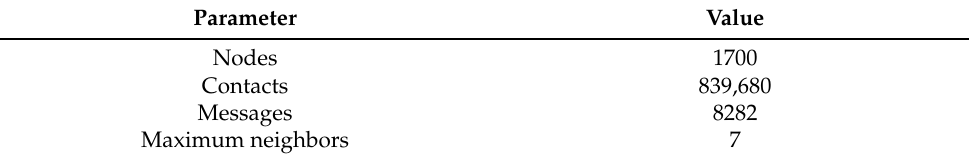
Table 3. Bluetooth trace output